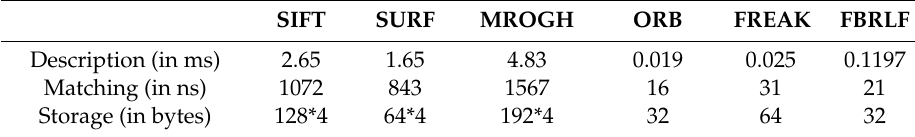
Figure 25. Average precision-recall curves for ORB, MROGH, SIFT, SURF, KAZE, A-KAZE, FREAK, BRISK, LATCH, DBRIEF and the proposed FBRLF on the Oxford data set. Table 6. Computation costs and storage requirements of different methods of a single descriptor.